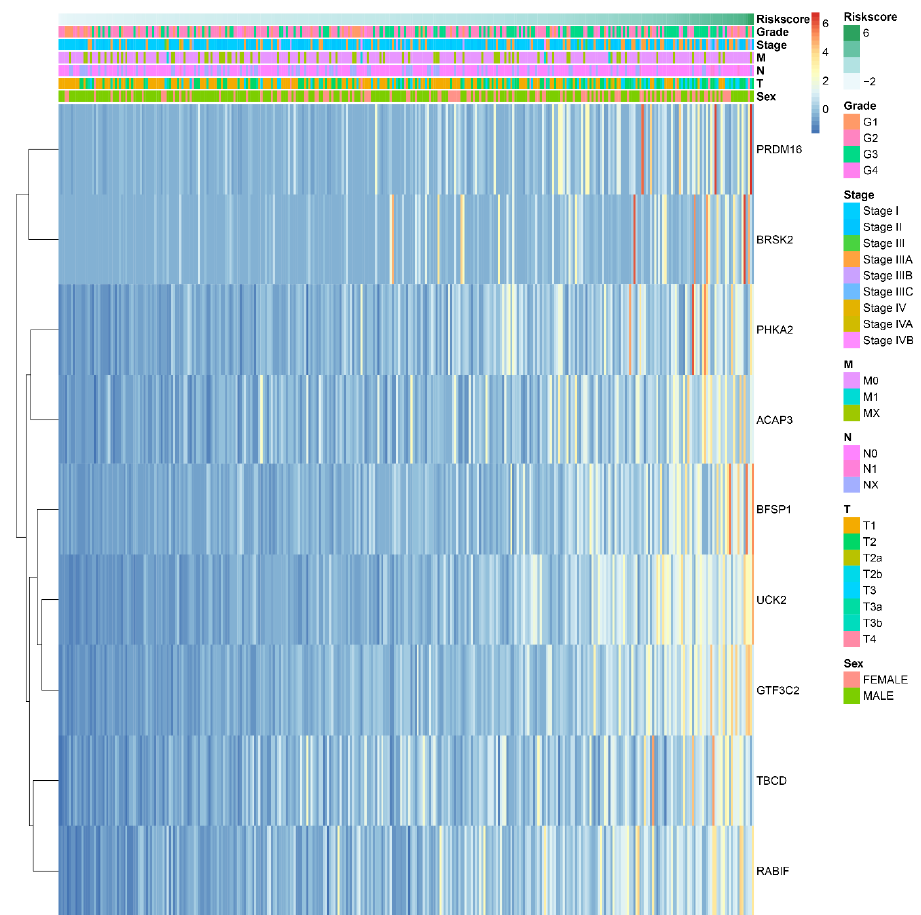
Figure 4. The heatmap of the expression of 9 survival-related m6A RNA methylation-related genes in the different risk groups. The distribution of clinical features was compared in the different risk group. Int. J. Mol. Sci. 2021 , 22 , x FOR PEER REVIEW